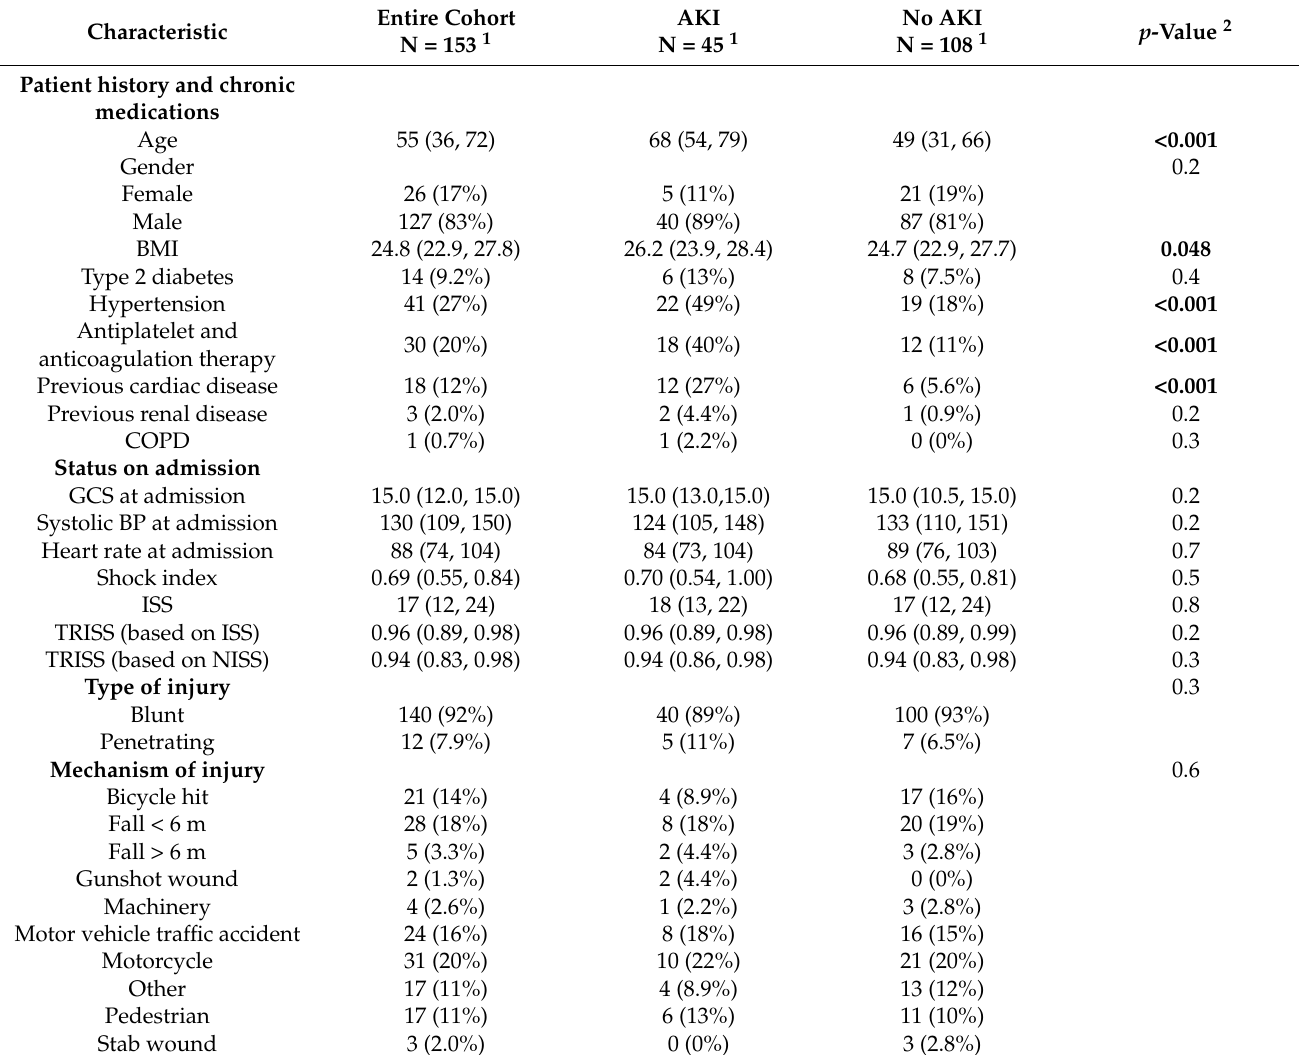
Table 1. Baseline characteristics, comorbidities, medications, and mechanism of injury in the overall population and according to AKI status.